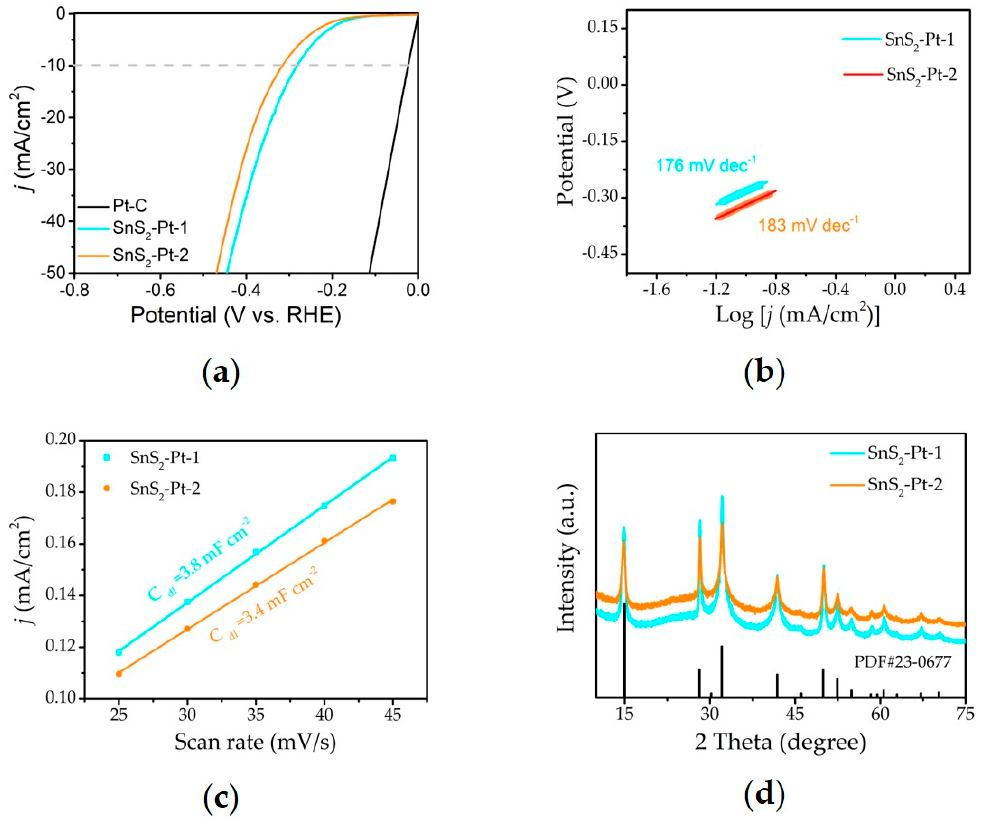
Figure 5. Structural and performance characterization of SnS 2 -Pt-1 and SnS 2 -Pt-2. ( a ) The LSV curves under hydrogen evolution. ( b ) The Tafel slopes. ( c ) Electrochemical active surface area. ( d ) XRD.